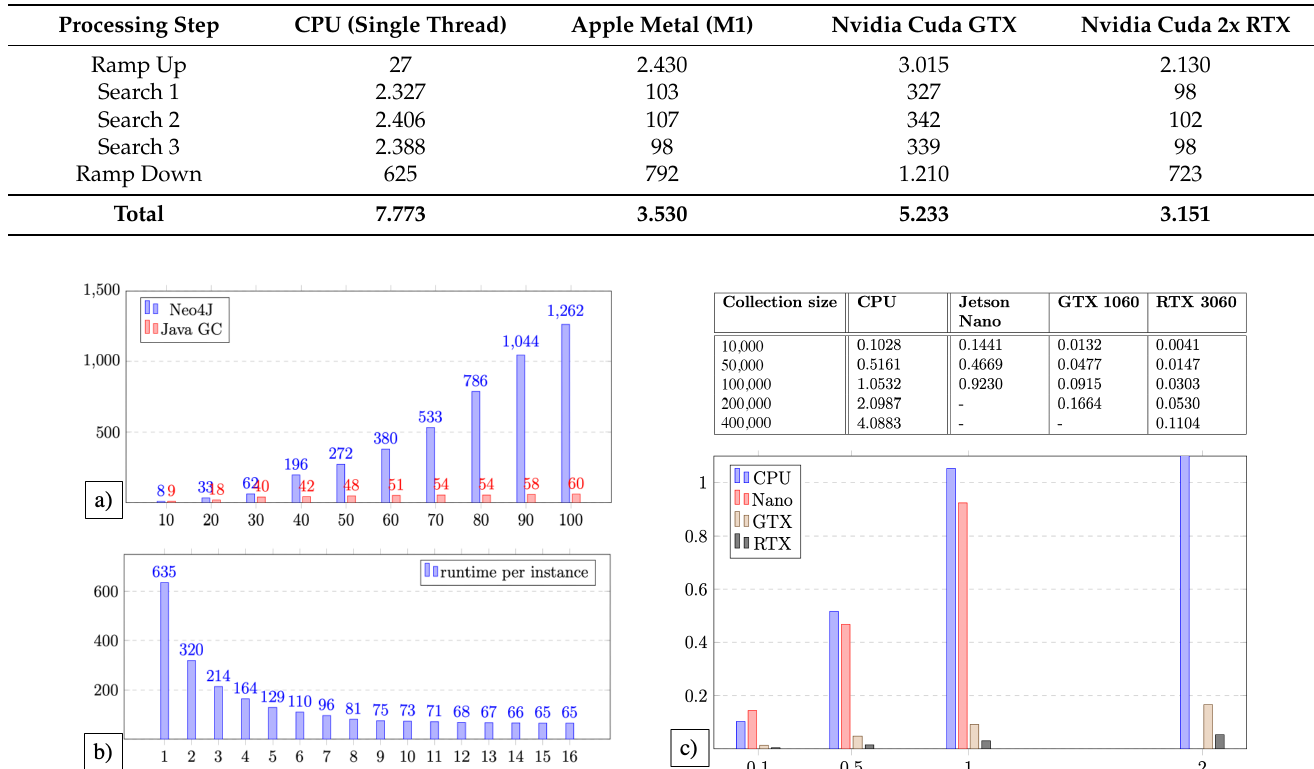
Table 6. Scalability, runtime measures (milliseconds) of vertical scaling on GPUs including ramp-up and ramp-down phases.